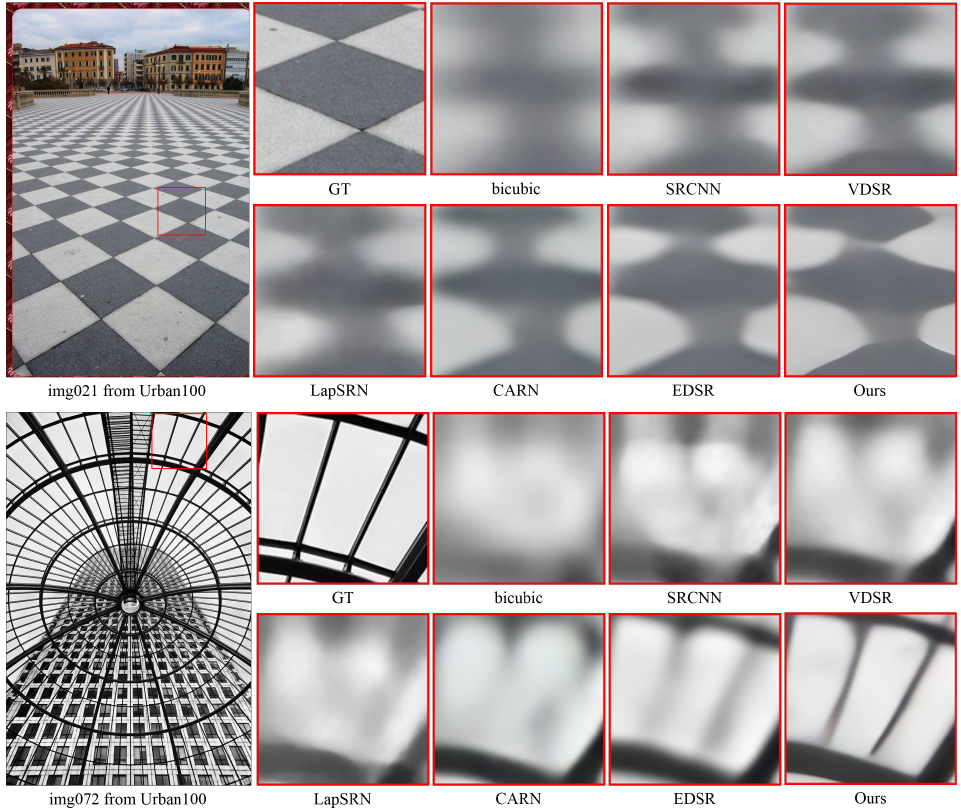
Figure 8. Qualitative comparison of image reconstruction results for × 32 magnification in Set14 and B100 datasets.